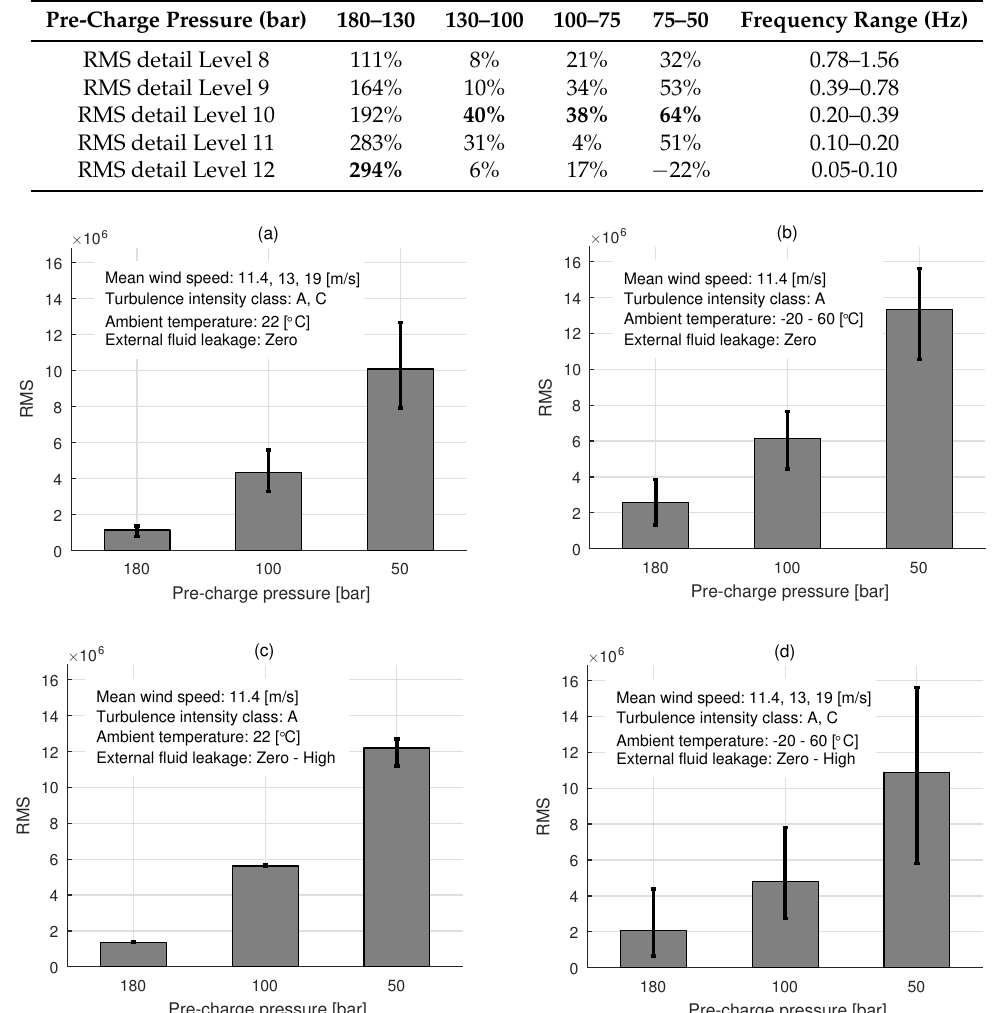
Table 3. Change in RMS values of the detail coefficient decomposition Levels 8–12 for nominal operating conditions. Change in percent is given with respect to the larger RMS value. Largest change in percent is marked in bold.